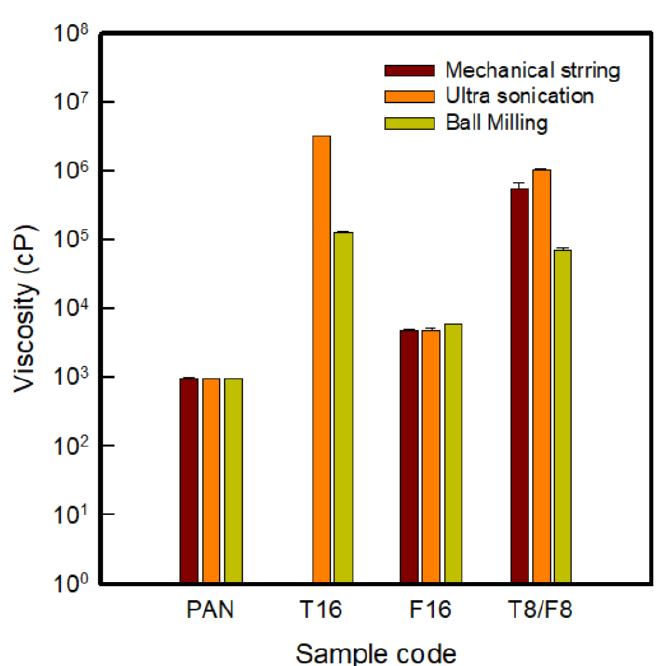
Figure 3. Viscosity of the PAN-based composite solution corresponding to the content of 16 wt% carbon nanomaterials by different dispersion methods.